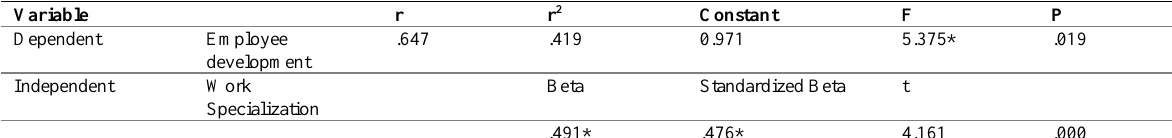
Table 7: Regression Analysis